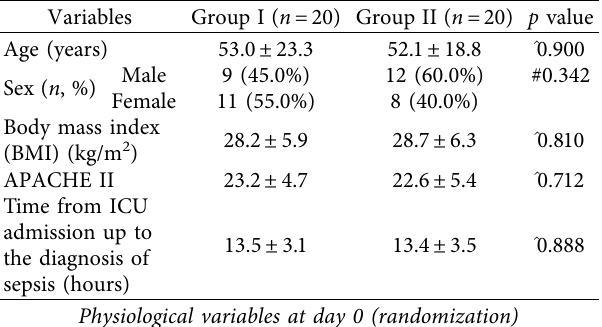
Table 1: Baseline demographic and clinical characteristics between the study